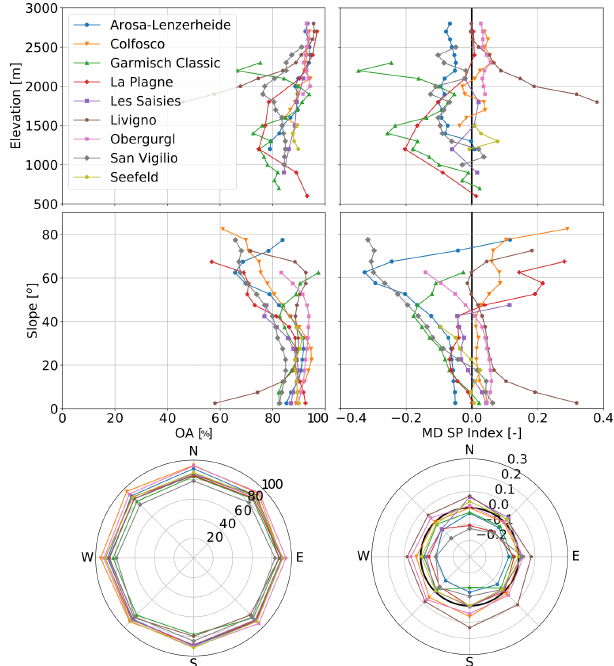
Figure A3. Comparison for 100m elevation bands, 5 ◦ slope bands, and 45 ◦ aspect bands for (left) overall accuracy between simulation and S2 data and (right) mean deviation (MD) SP index between simulation and S2 data. All the metrics are computed for natural snow